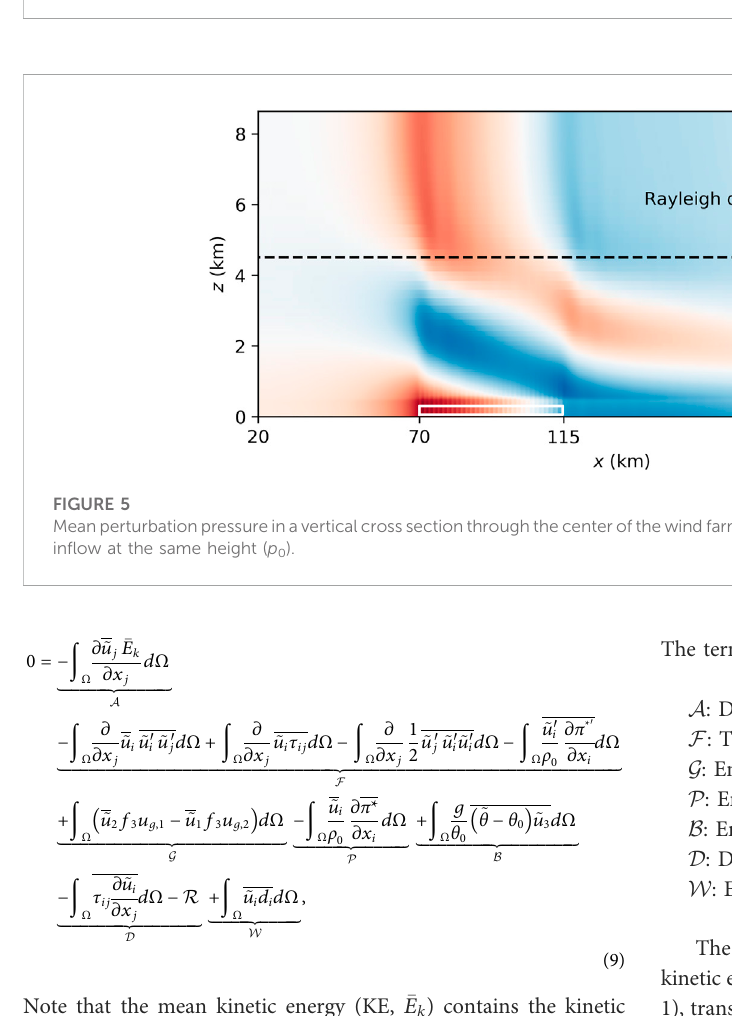
FIGURE 4 Inversion layer displacement. A rolling average with a window size of one turbine spacing in x - and y -direction is applied. The borders of the wind farm are marked by white lines.